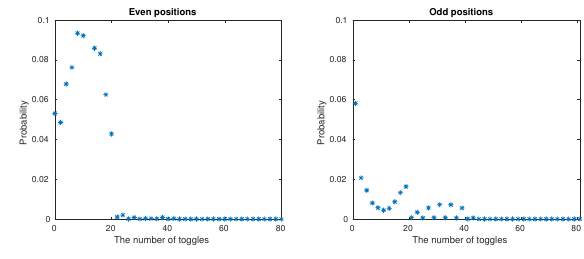
Figure 9: Toggles probability distributions predicted by the model and obtained by experiments. Each distribution is shown using two graphs, one for the even values (left) and one for the odd values